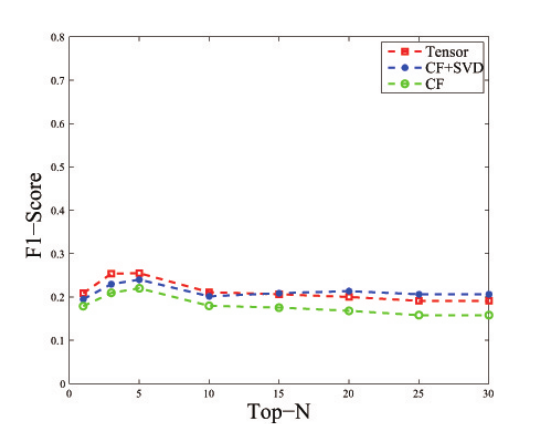
Fig. 6. The recall rate of Tensor and CF